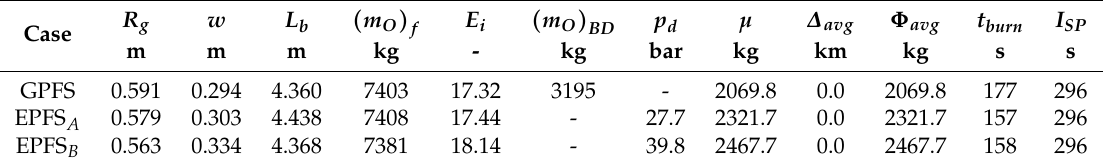
Table 5. Design parameters and